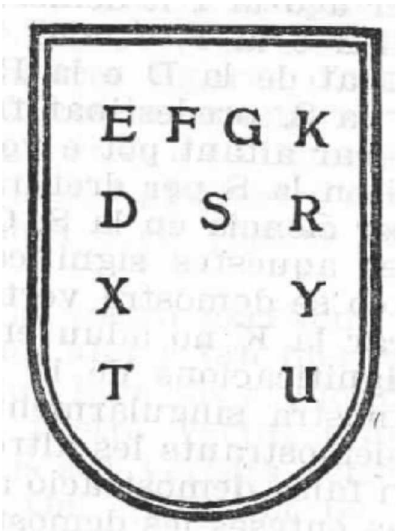
Figure 3. Chapter 335, Llibre de contemplació, Obres essencials, Volume 2, p.